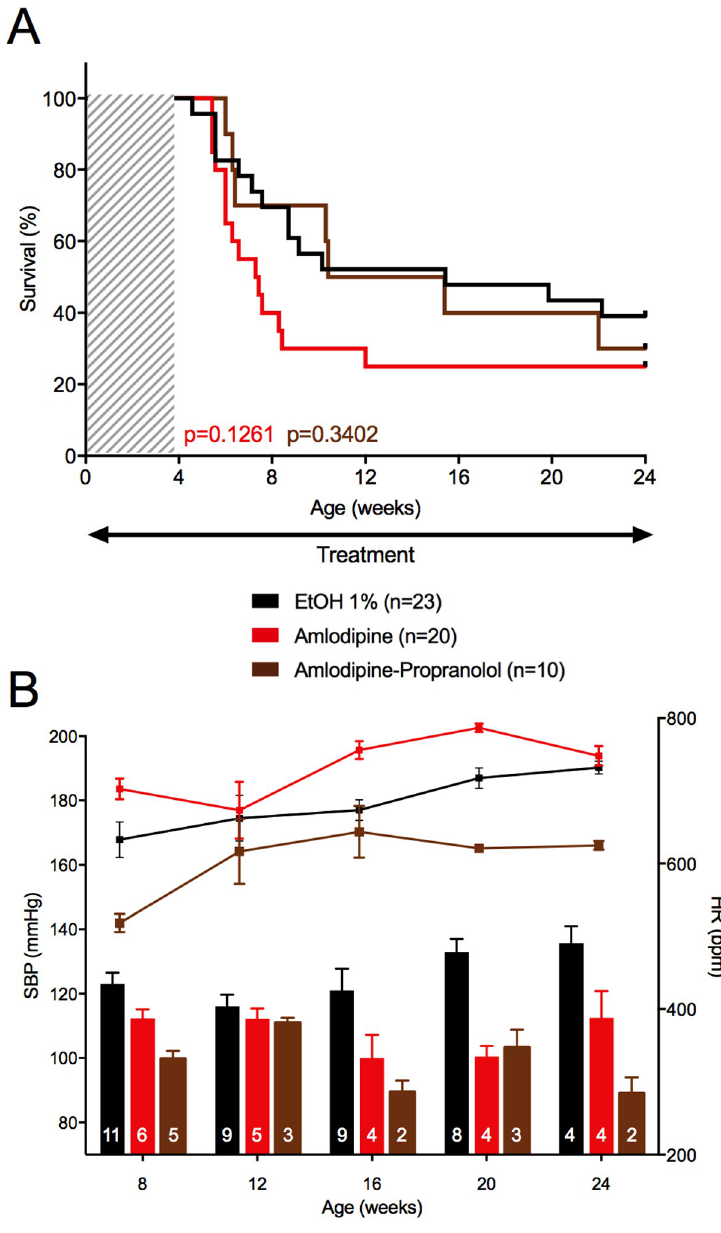
Fig 7. Consequences of treatment by amlodipine and the association amlodipine-propranolol. The upper panel represents the survival curves on either active treatment or water. The lower panels represent SBP (lower bars: left scale) and HR (upper lines: right scale), measured between 8 and 24 weeks. Data are expressed as mean ± SEM. Numbers within the bars indicate the number of living mice studied at each time of measurement. A Survival comparison between Amlodipine and ethanol 1%, and between the association amlodipine-propranolol and amlodipine (monotherapy). Kaplan-Meier Survival curve (red curve) for comparing Col3a1 +/G182R treated with amlodipine (n = 20) to Col3a1 +/G182R treated with ethanol 1% (n = 23). Insignificant difference is calculated using Log- Rank (Mantel-Cox) analysis (p = 0.1261). Kaplan-Meier Survival curve (brown curve) for comparing Col3a1 +/G182R treated with amlodipine-propranolol (n = 10) to Col3a1 +/G182R treated with amlodipine (n = 20). Insignificant difference is calculated using Log-Rank (Mantel-Cox) analysis (p = 0.3402). B SBP and HR comparison between amlodipine and ethanol 1%, and between the association amlodipine-propranolol and amlodipine (monotherapy). SBP was slightly lower in the treated group (student t-test, p > 0.05 throughout the follow-up period except at 20 weeks) and HR was slightly increased (student t-test, p < 0.05 at 16 and 20 weeks) when comparing amlodipine to ethanol 1% (red bars and curve). SBP remained unchanged throughout the follow-up period (Student-t test, except at 8 weeks, p = 0.0086) and HR decreased significantly (student t-test, p < 0.05 throughout the follow-up period, except at 12 weeks) when comparing amlodipine-propranolol to amlodipine (monotherapy, brown bars and curve).